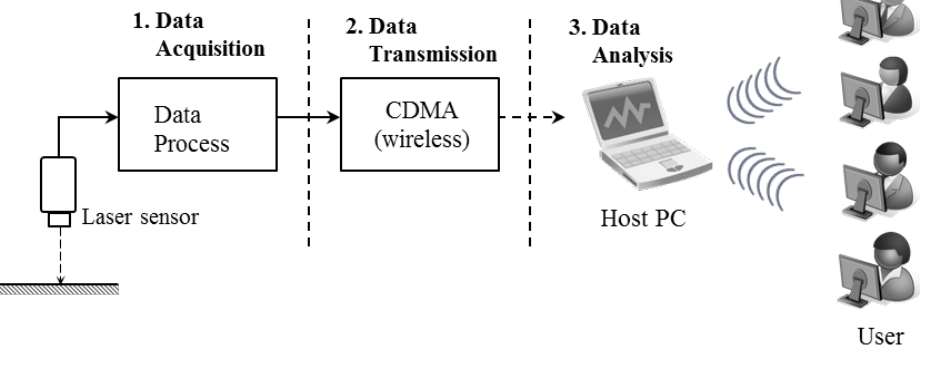
Figure 1. Data transmission process for the